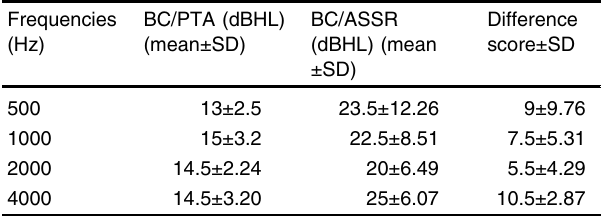
Table 3 BC/PTA and BC/ASSR thresholds and the difference score in children with mild-to-moderate SNHL ( n = 36 ears)